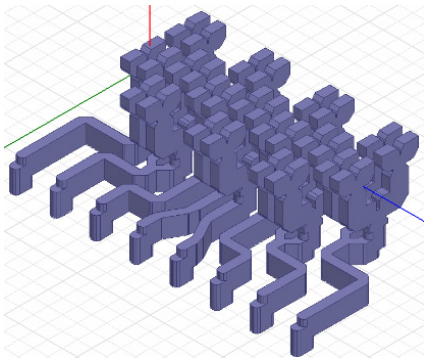
Figure 10. The simulation model of the one-dimensional phased array based on a triangular ar- rangement.